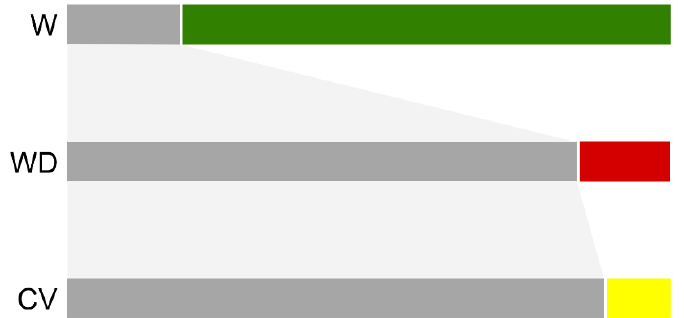
Figure 2. The proportion of different haplotypes of the sh4 gene in wild (W), weedy (WD), and cultivated (CV) rice samples. The gray bars represent haplotypes shared by all three taxa. The green, red, or yellow bars represent the proportions of unique haplotypes in the examined wild, weedy, or cultivated rice samples.